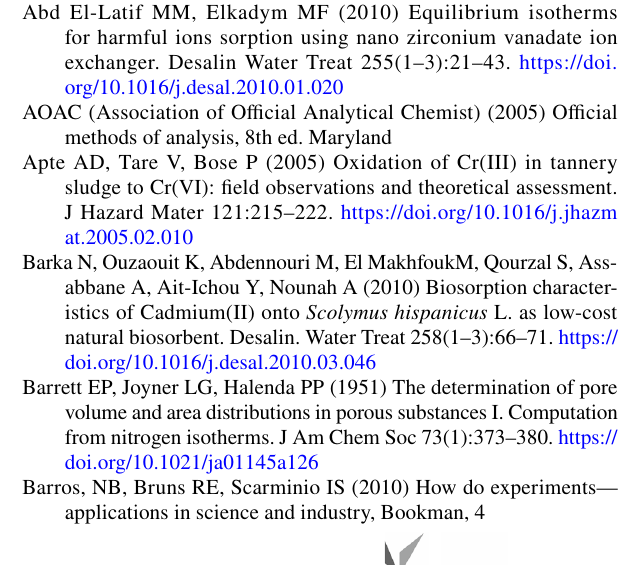
2+ , Pb 2+ , Cr 3+ on the shell of the cashew nut (CNS) in natura